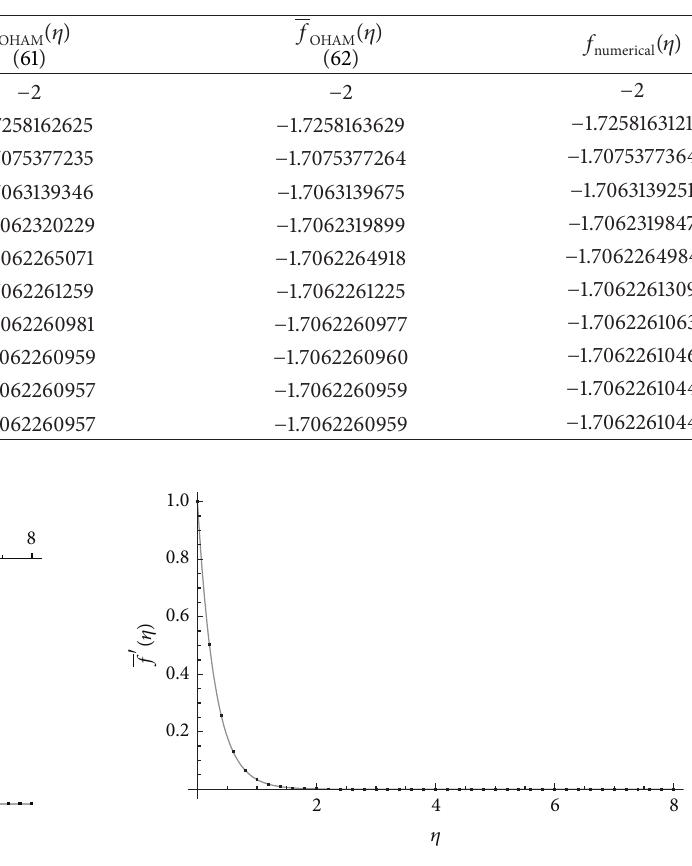
Table 5: Comparison of the first-order approximate solution 𝑓 obtained by OHAM with numerical results.